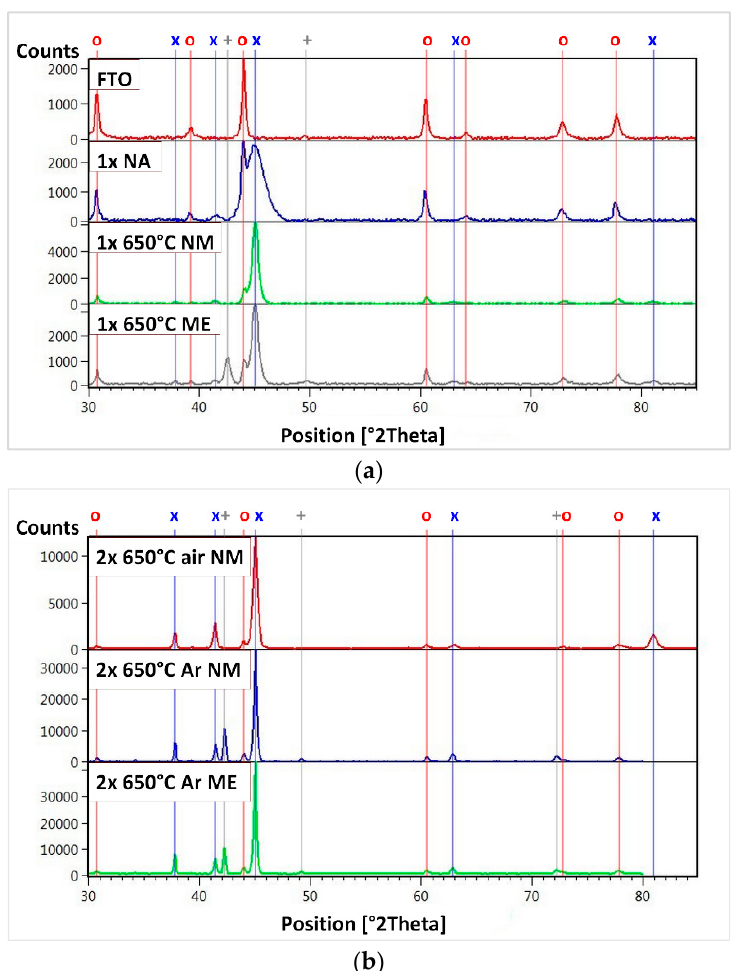
Figure 5. X-ray diffraction (XRD) of fluorine doped tin oxide (FTO) glass and samples 1x ( a ), 2x ( b )—effect of post deposition annealing and photoelectrochemical polarization; o SnO 2 ; × CuO; + Cu 2 O; NA—as deposited; 650 °C NM—annealed at 650 °C before photoelectrochemical polarization; 650 °C ME—annealed at 650 °C after photoelectrochemical measurement.